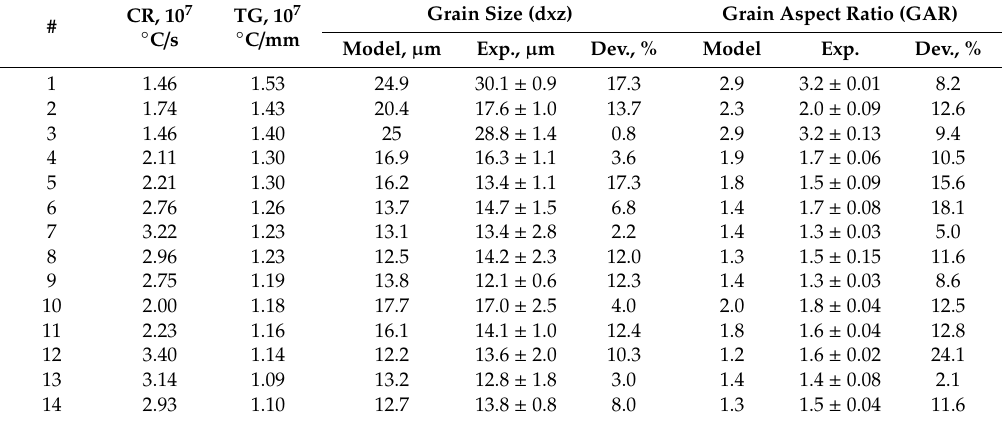
Table 3. Grain size (dxz) and grain aspect ratio (GAR) approximation-experiment comparison with deviations.